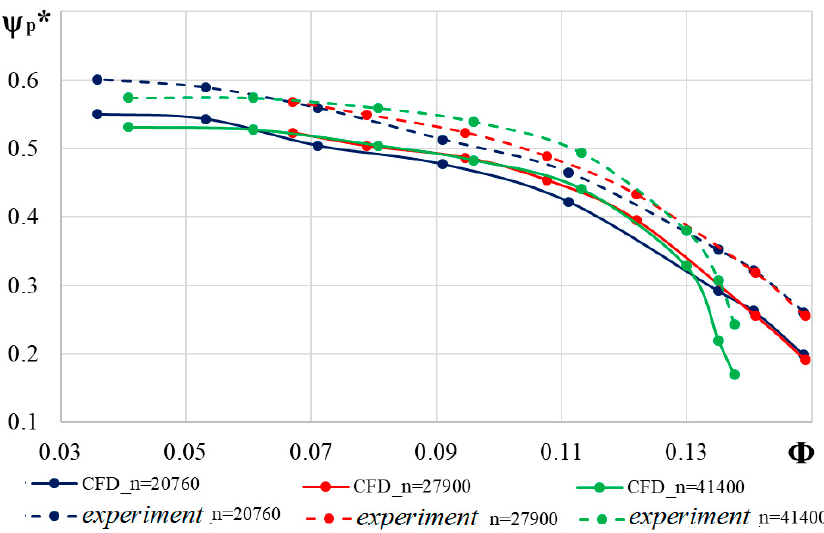
Figure 15. Characteristics of the polytropic work coefficient TKR 140E.